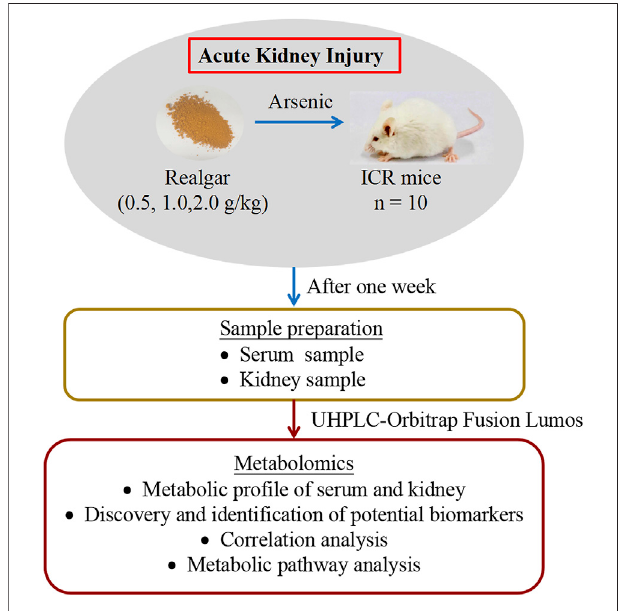
FIGURE 1 | Experimental procedure of ICR mice exposed to